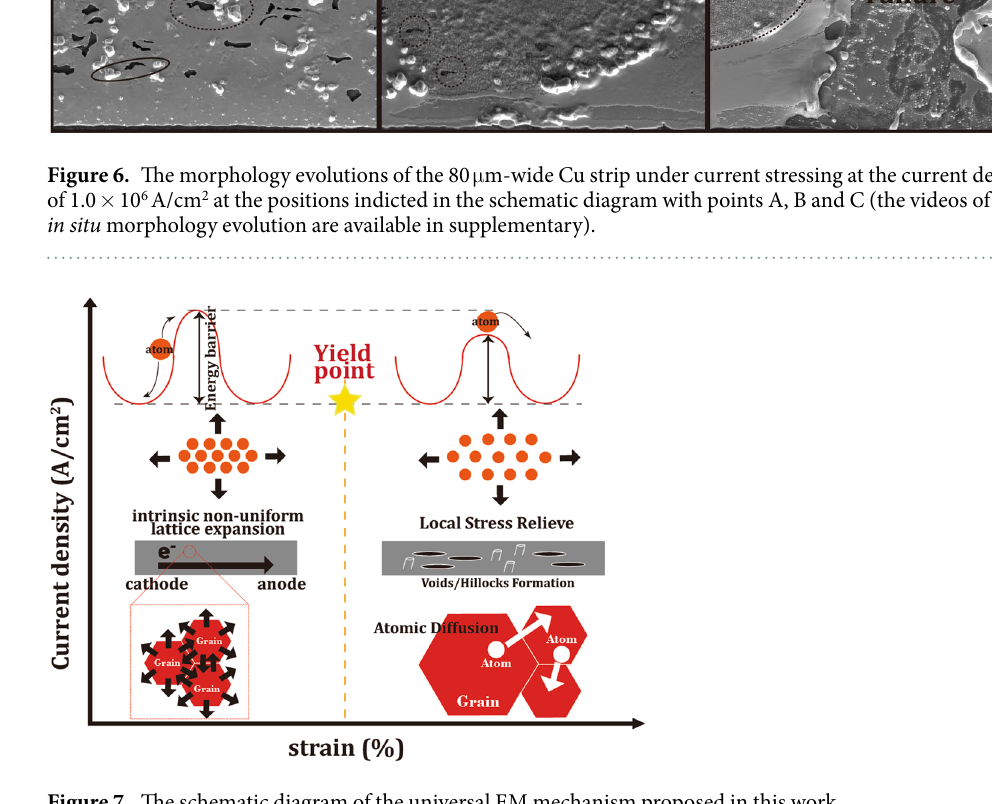
deformation and the occurrence of EM-induced failures. In contrast, the pre-existing compressive stress in mate- rials helps hinder the total tensile strain from the yield point. (2) Adding rigid cap-layers on metal strips delayed